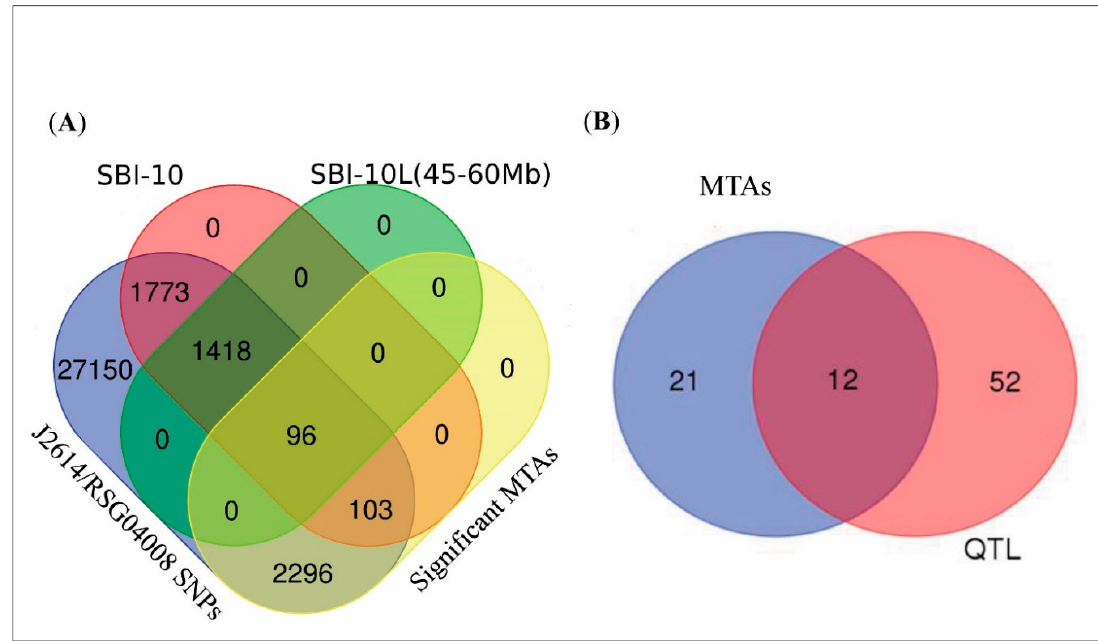
Figure 6. SNPs distribution on SBI-10L for the stay-green trait, chromosome, and genomic region. Venn diagram illustrating significant SNPs and common genes in MTAs and QTL studies for J2614 / RSG04008-6. ( A ) Whole-genome scan SNPs, SBI-10 SNPs, SBI-10L SNPs, and the significant MTAs represented in the Venn diagram, and the ( B ) common genes identified by the stay-green MTAs and the QTL fine-map represented in the Venn diagram.